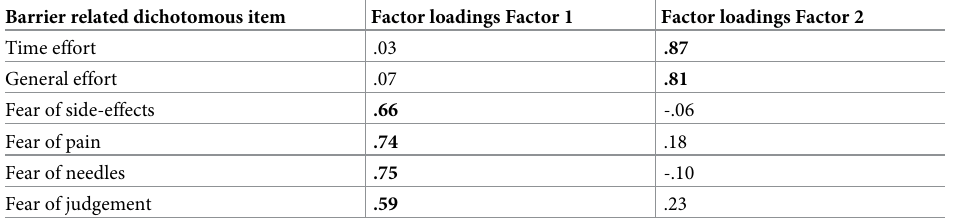
Table 3. Factor loadings of barrier related items on underlying constructs with an eigenvalue of > 1 as determined by latent class analysis. Barrier related dichotomous